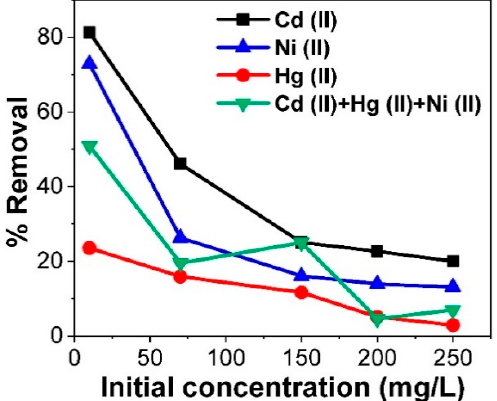
ffi ciency or mono-metal and ternary experiments at pH Figure 7. Removal efficiency or mono-metal and ternary experiments at pH 4.5. Figure 7. Removal e